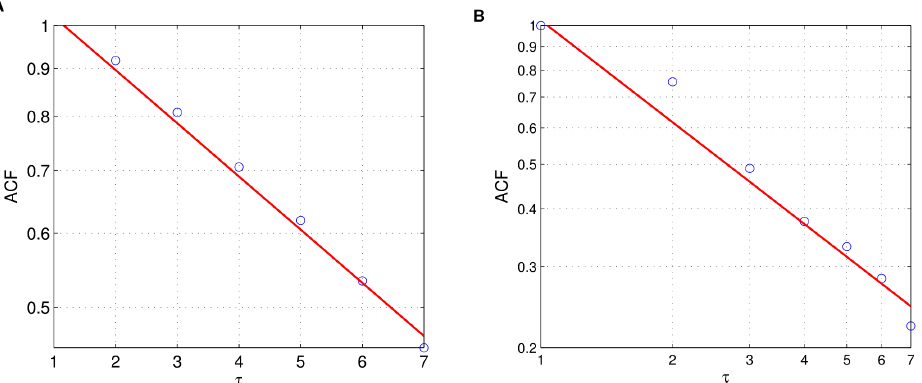
Figure 3. Gowalla: Temporal short- and long-term correlations in the population growth rate. Short-term correlations for S 0 v S (cid:2) (log-lin plots), C ( t ) * e { ct , and long-term correlations for S 0 § S (cid:2) (log-log plots), C ( t ) * t { d . Fits using MLE suggest c ~ 0 : 13 ( R 2 ~ 0 : 992 ), d ~ 0 : 73 ( R 2 ~ 0 : 955 ); log-log-scaling for determining the coefficient of determination for the power law, and log-linear-scaling for the exponential.